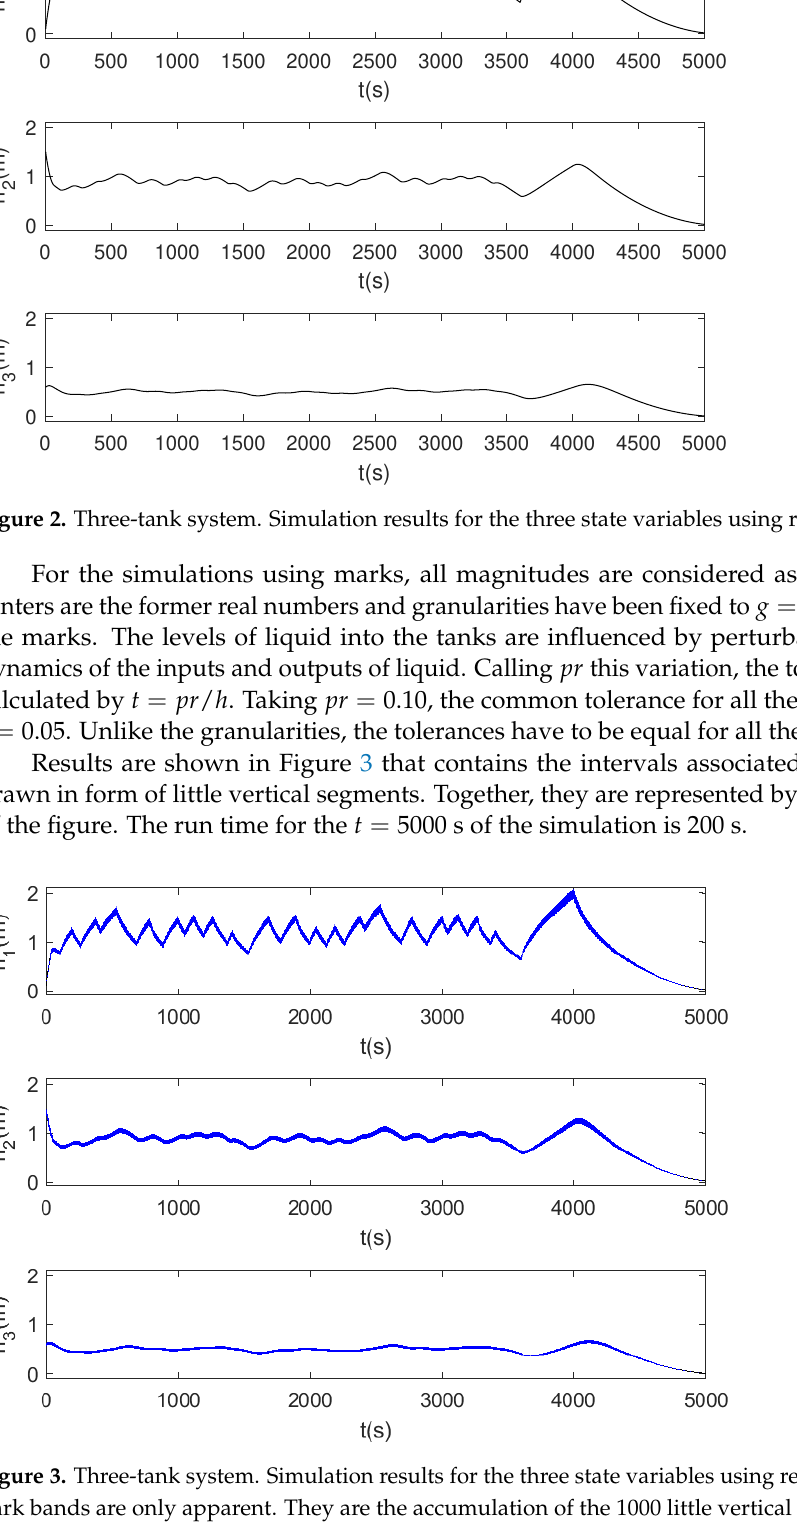
Figure 2. The intermittent input flow gives the sawtooth shape for the values of h 1 . 208